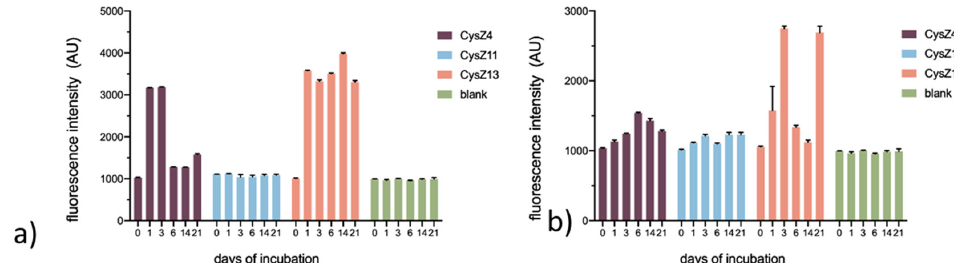
Figure 4. Dependence of the fluorescence intensity signal of the peptide-thioflavin T complex at 482 nm on the time of incubation relative to a control (Thioflavin T–blank) in PBS ( a ) pH 4.0; ( b ) pH 7.4. Results are presented as mean and standard error of mean (SEM).